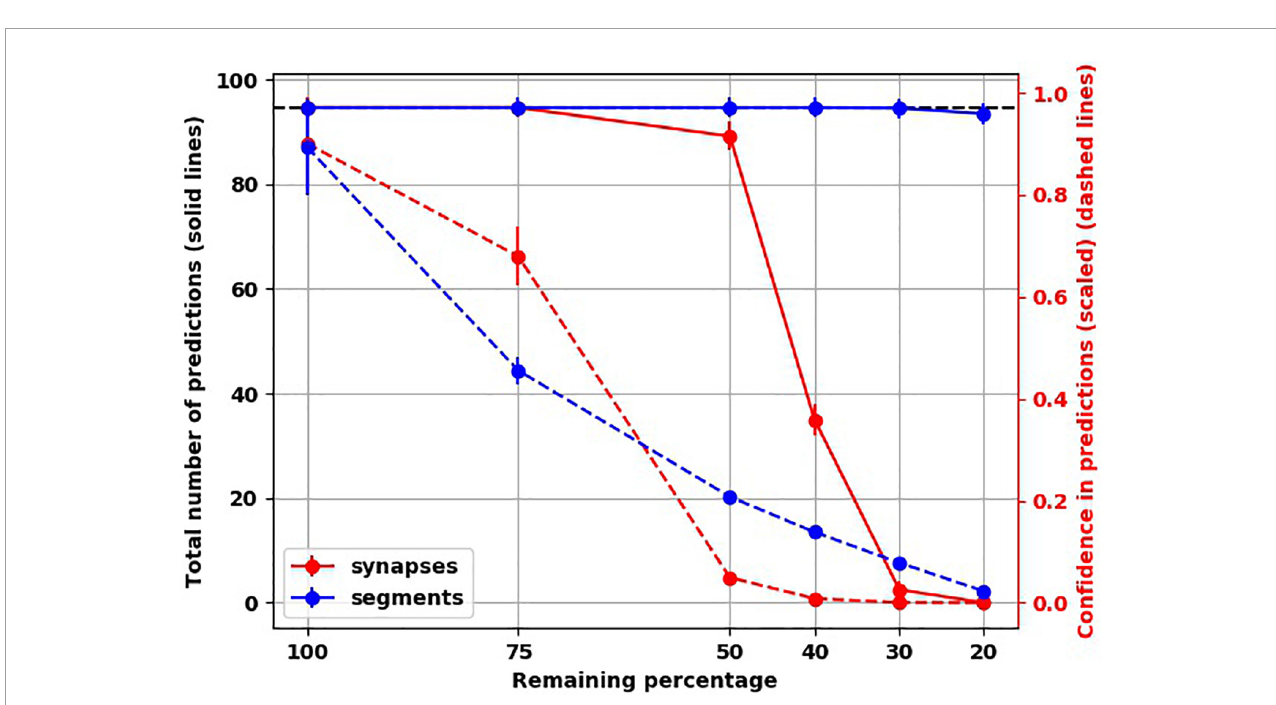
FIGURE5 Unlike loss of synapses, loss of connections along dendritic segments affected confidence (dashed lines) but not number of predictions (solid